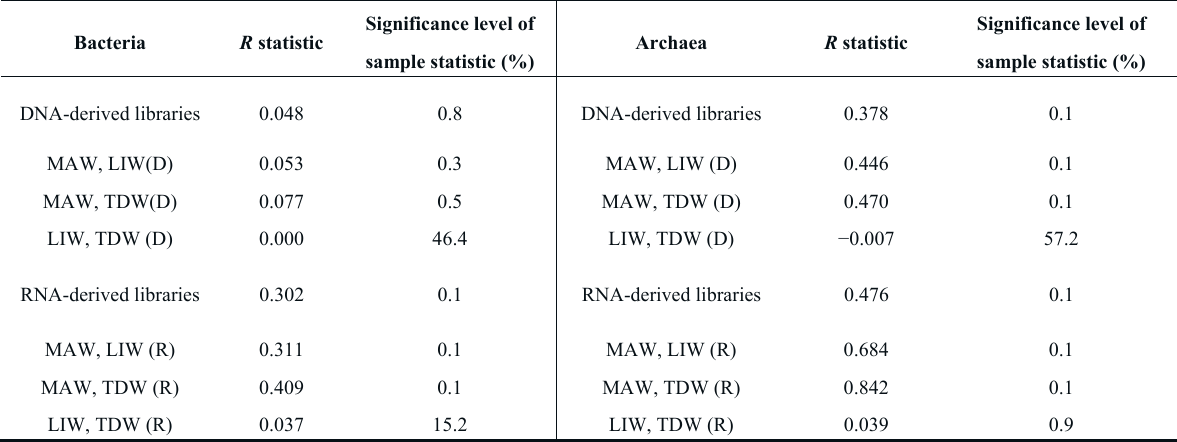
Table 4 . ANOSIM result between bacterial and archaeal clone libraries obtained from different depths in Station Vector; (D: 16S rDNA-derived library; R: 16S